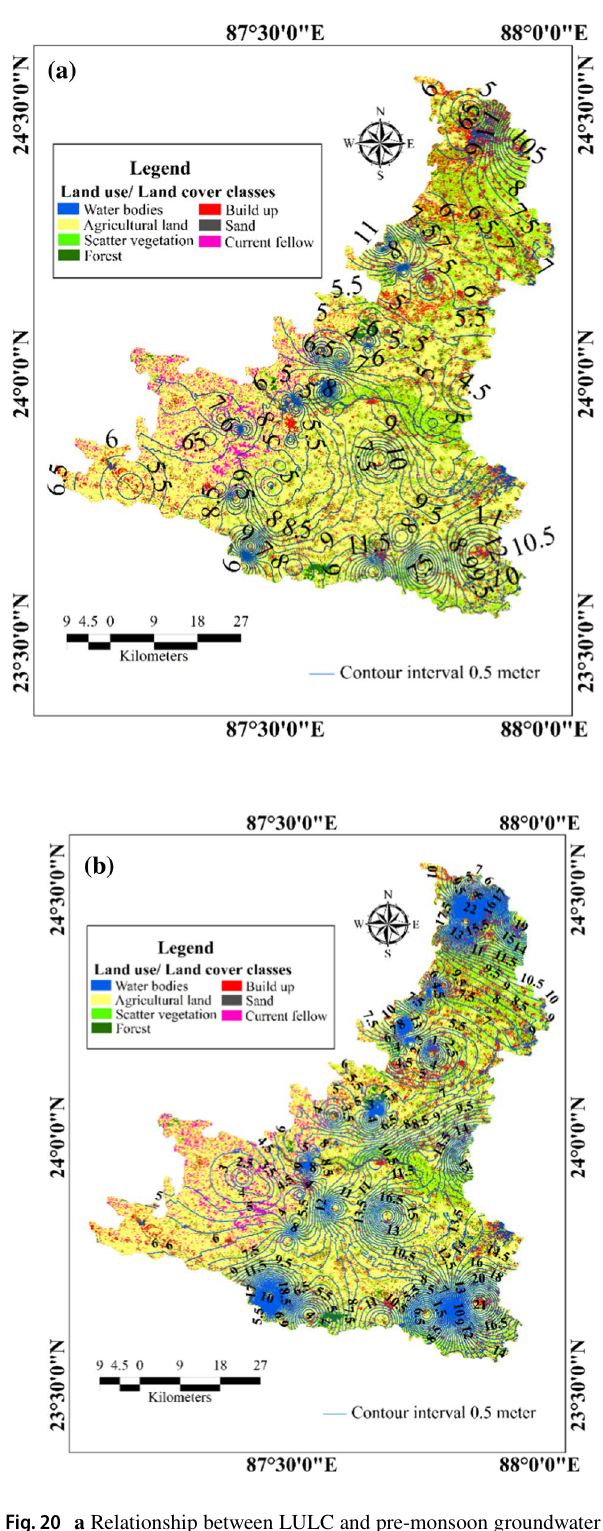
Fig. 20 a Relationship between LULC and pre-monsoon groundwater level, 1996. b Relationship between LULC and pre-monsoon ground- water level,